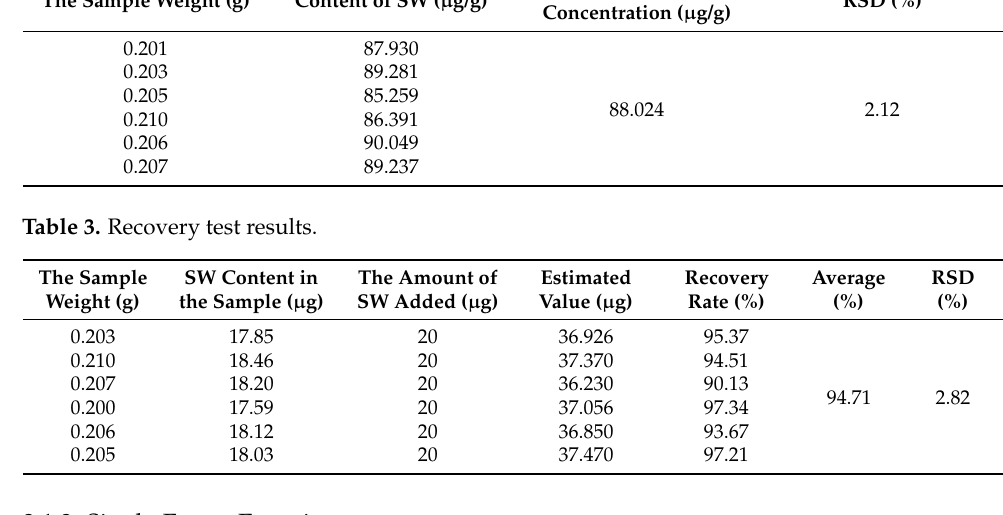
Table 2. Repetitive experiment results.